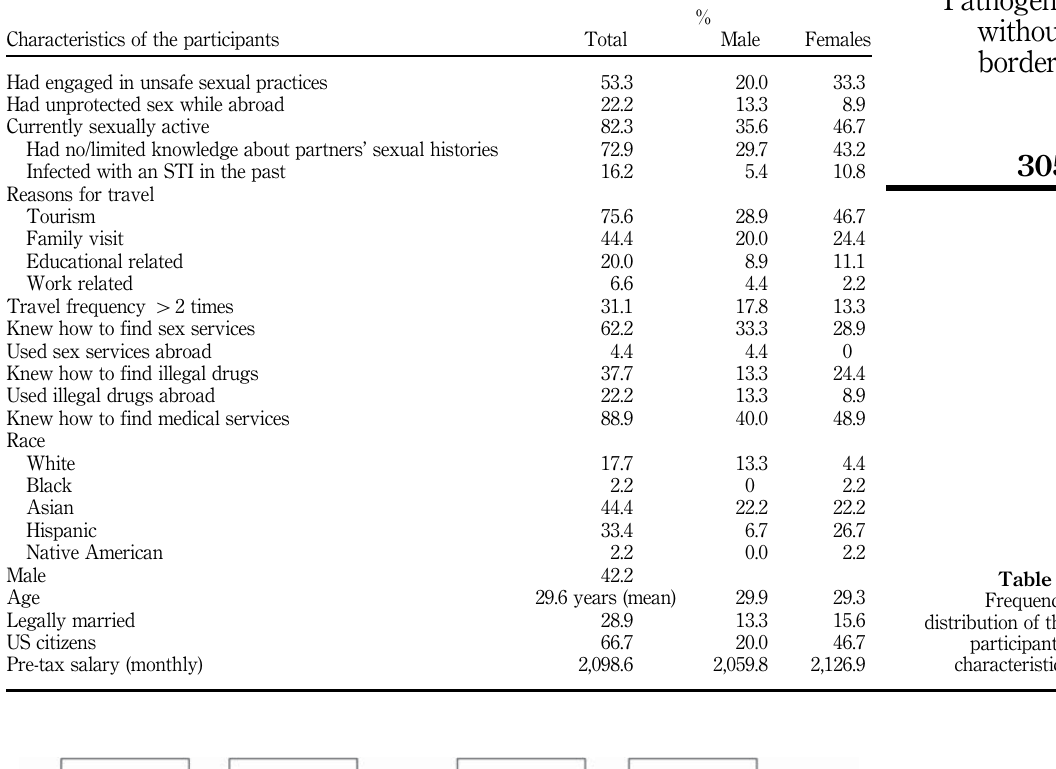
Figure 2. Ecological